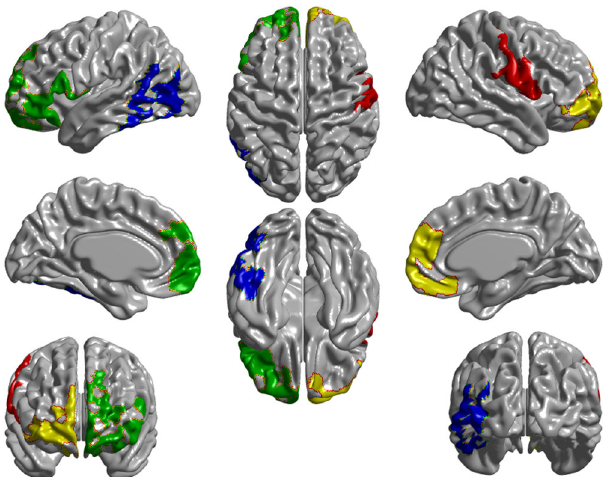
Fig. 2 Signi fi cant clusters of cortical thinning in PD. Four peak clusters of cortical thinning in PD were identi fi ed in parts of (1) left occipital lobe (nverts = 1081 [5.53 resels], p < 0.0001, (2) left frontal lobe (nverts = 2115 [10.99 resels], p < 0.0001), (3) right frontal lobe (nverts = 3720 [15.79 resels], p < 0.0001), and (4) right somatomotor cortex (nverts = 1990 [16.56 resels], p < 0.0001). nverts: number of vertices in the signi fi cant and post-central gyrus and supramarginal gyrus (Fig. 2). The frontal lobe atrophy mostly involved the inferior parts of lateral and medial frontal cortex, including the orbitofrontal cortex, frontal pole, ventromedial, and rostral dorsomedial prefrontal cortex. On the lateral surface, inferior and medial frontal gyri were implicated, with extension to the superior frontal gyrus on the left. In order to assess the likely functional consequences of cortical thinning in PD, we assigned each cortical parcel to one of the seven intrinsic brain networks derived from resting-state functionl MRI (fMRI) by Yeo et al. 28 . Cortical regions belonging to the limbic, frontoparietal, and ventral attention networks on average demonstrated the greatest cortical thinning, as well as anterior parts of the default mode network (DMN; Fig. 3). There were no areas showing greater loss of cortical thickness in HC than in PD.